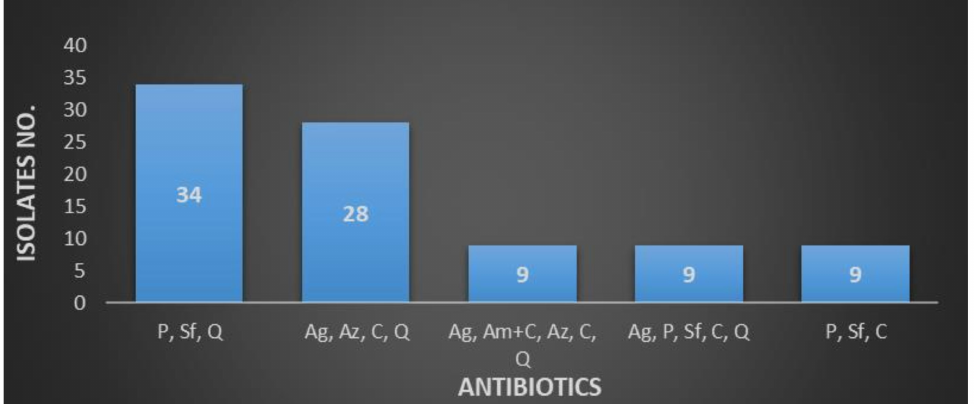
Figure 3. Escherichia coli resistance profiles of MDR strains (Ag—aminoglycosides, Am + C— aminopenicillins + β -lactams inhibitor, Az—aztreonam, C—cephalosporins, P—penicillin, Q—quinolones, and Sf—sulfonamides).